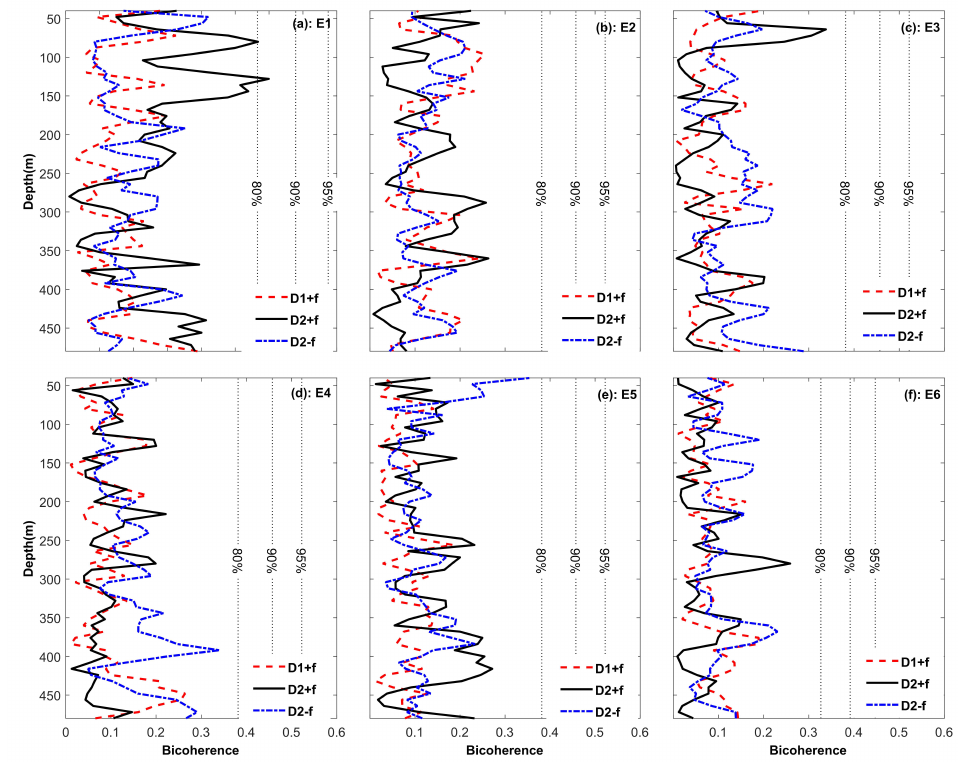
Figure 8. Bicoherence between near-inertial frequency ( f ) and D1 + f (red lines), D2 + f (black lines), and D2-f (blue lines) frequency detided zonal currents. Figures ( a – f ) correspond to episode 1 to 6, and the black vertical lines denote the 80%, 90%, and 95% confidence intervals, respectively. D1 and D2 represent the diurnal and semi-diurnal frequency, respectively.